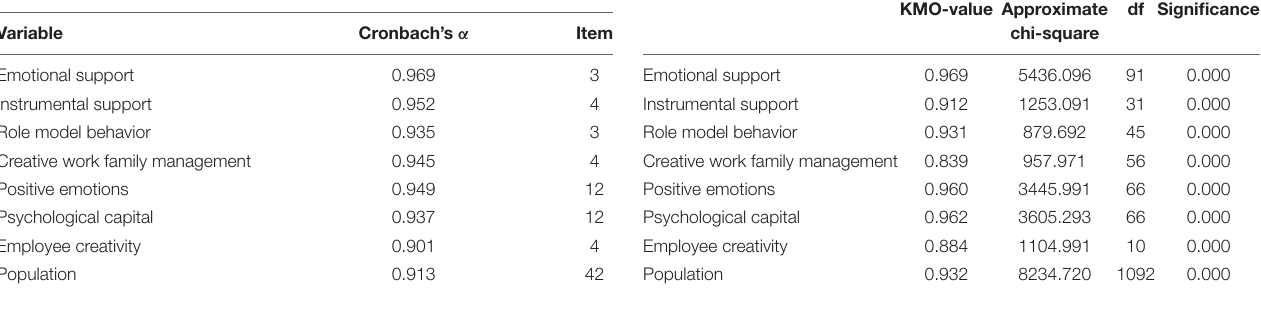
TABLE 2 | Reliability analysis of variables.